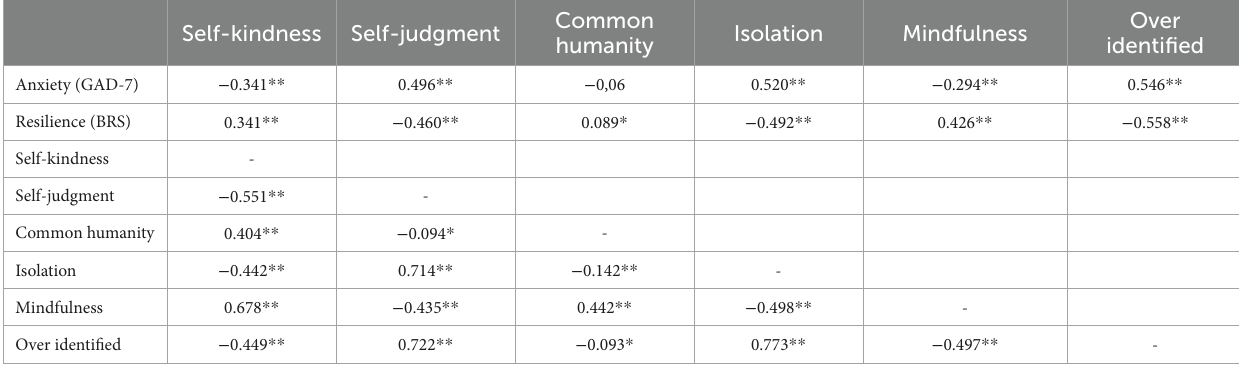
TABLE 5 Construct